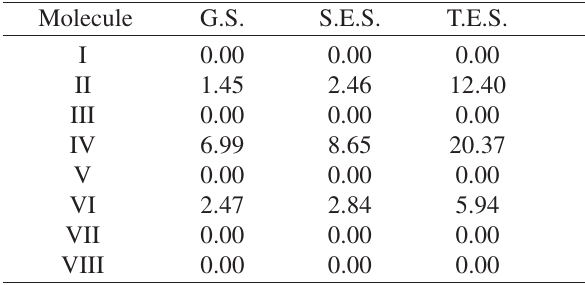
Table 3. Dipole moment (in Debye ) for neutral and excited (sin- glet and triplet) states of the alkynes presented in Table 1. (G.S., S.E.S. and T.E.S correspond to ground, singlet excited and triplet excited states, respectively).